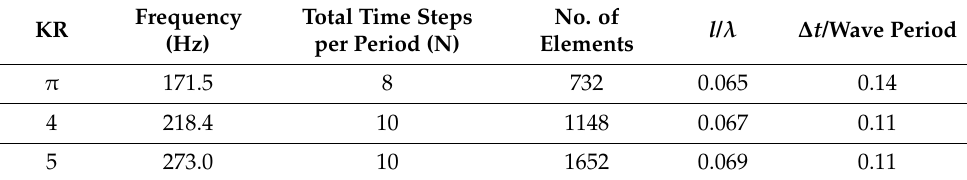
Table 1. The selected frequencies and computing conditions for the pulsating sphere.